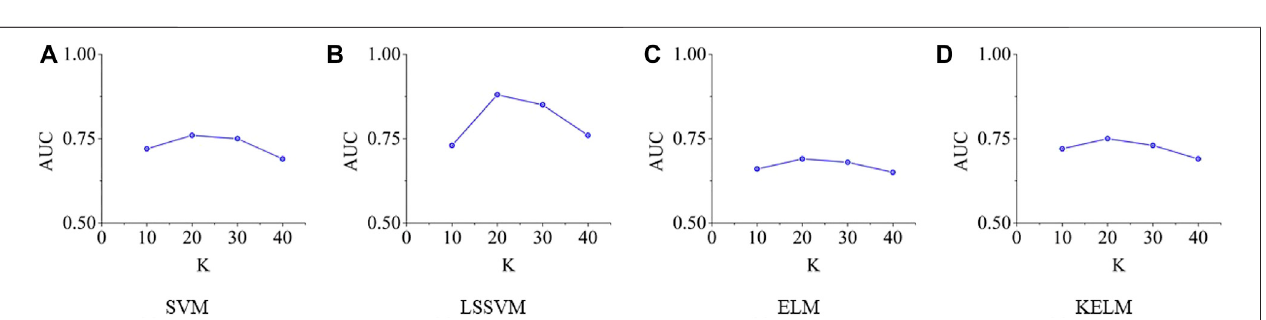
FIGURE 7 | The AUCs of all classi fi cation algorithms under different dimensions of EWMA vectors.